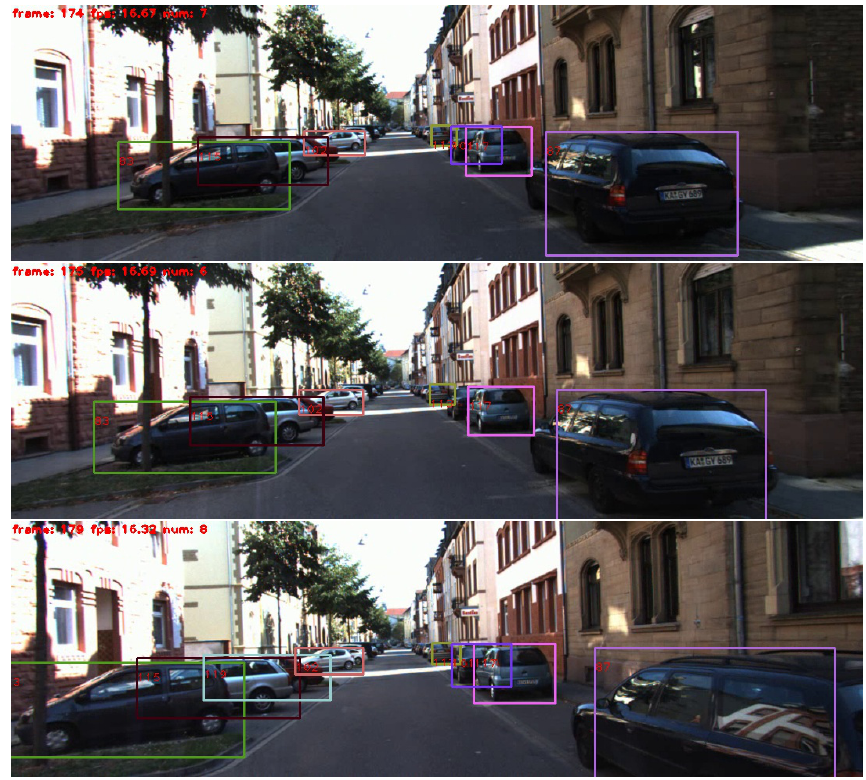
Figure 5. Three-frame tracking results on test sequence 00 of the KITTI tracking